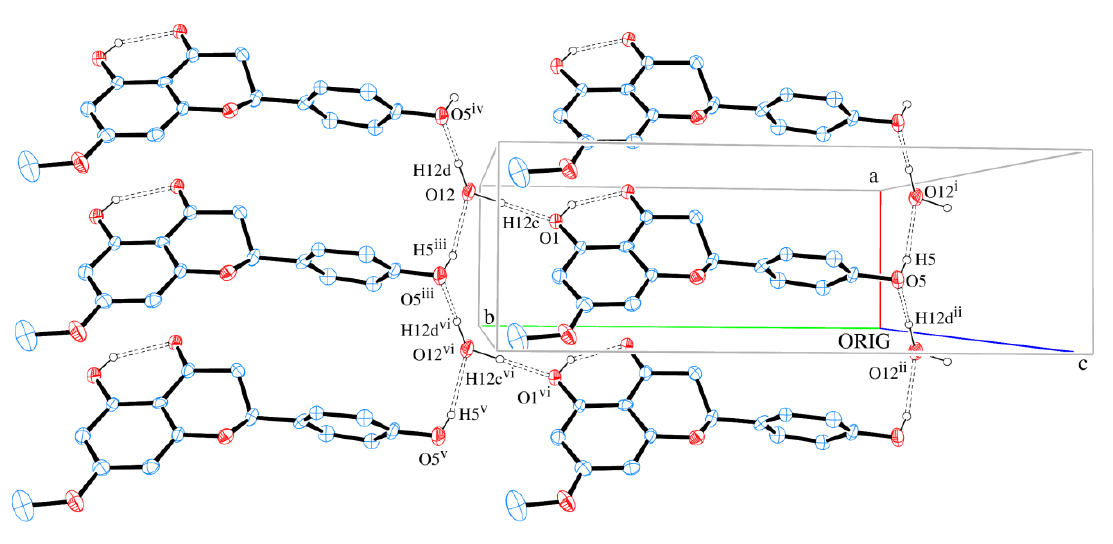
Figure 6. A section of the supramolecular 2D assembly of sakuranetin-monohydrate (Molecule A), projected onto (001). The chains propagation along [100] and [010] are evident. Hydrogen bonds are shown as dashed lines. Displacement ellipsoids are drawn at the 30% probability level. H of carbon atoms were omitted for clarity. [Symmetry codes: (i) x, y − 1, z; (ii) − x, − y, z; (iii) x, y + 1, z; (iv) x + 1, y + 1, z; (v) x − 1, y + 1, z; (vi) x − 1, y, z].